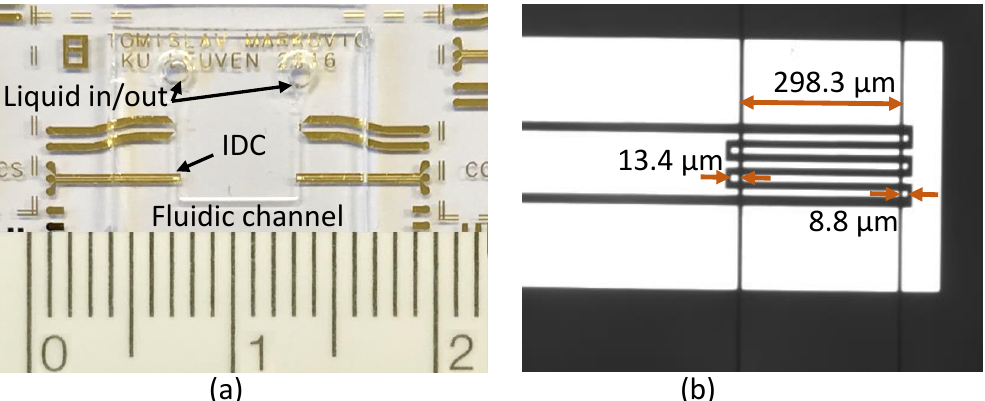
Figure 3. ( a ) Image of the fabricated sensor. ( b ) Microscope image of the fabricated IDC with measured